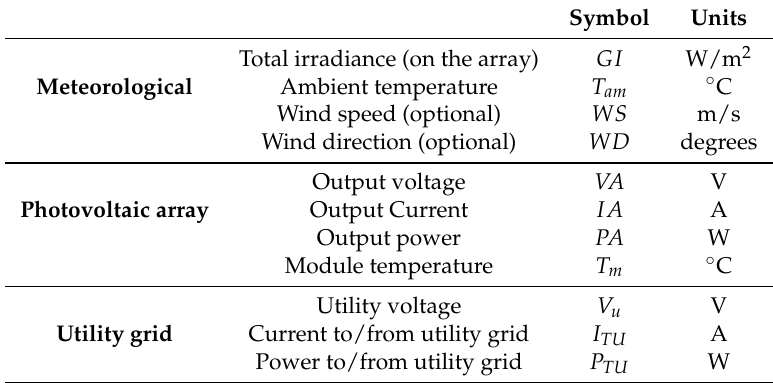
Table 1. IEC-61724 standard